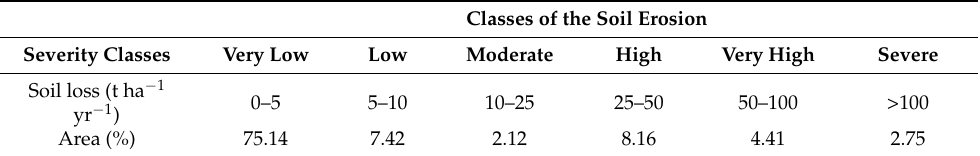
Figure 4. Maps of the Revised Universal Soil Loss Equation (RUSLE) factors for the Kagera basin (KB); ( a ) rainfall erosivity factor; ( b ) soil erodibility factor; ( c ) slope length factor, ( d ) slope factor; ( e ) cover management; ( f ) soil erosion. Table 3. Soil erosion severity classes of the KB.